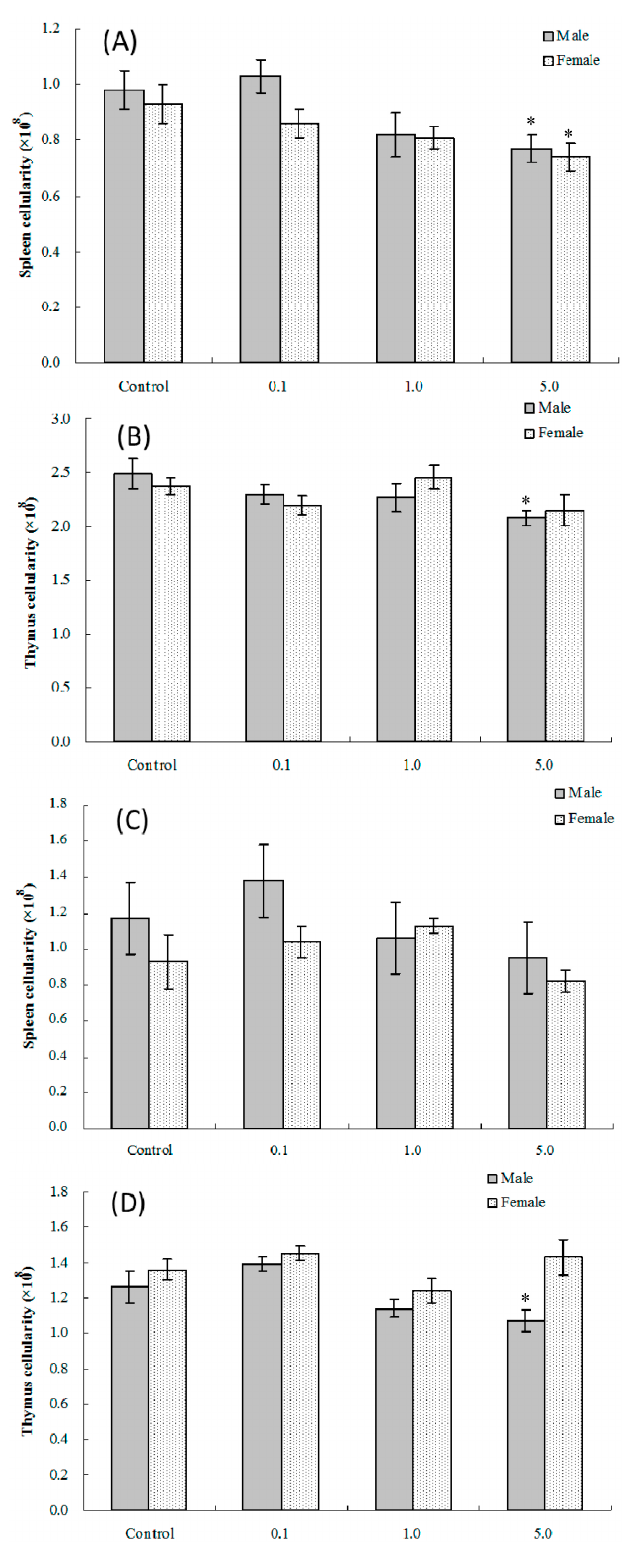
Figure 1. Splenic and thymic cellularity in C57BL/6 pups exposed in utero to PFOS during GD 1–17. Mice at ( A , B ) four and ( C , D ) eight weeks of age. Data shown are the mean ± SEM. * Value significantly different from respective controls ( p ≤ 0.05) by the one-way ANOVA test. All data were log-transformed as required for statistical analysis. n = 12 each group.